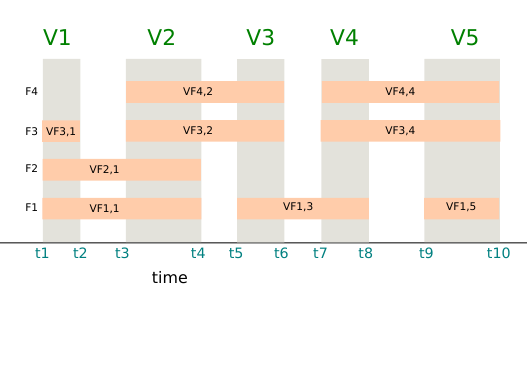
Figure 3. Versionable features of city objects. F1, F2, F3 and F4 are unique identifiers of features of city objects.